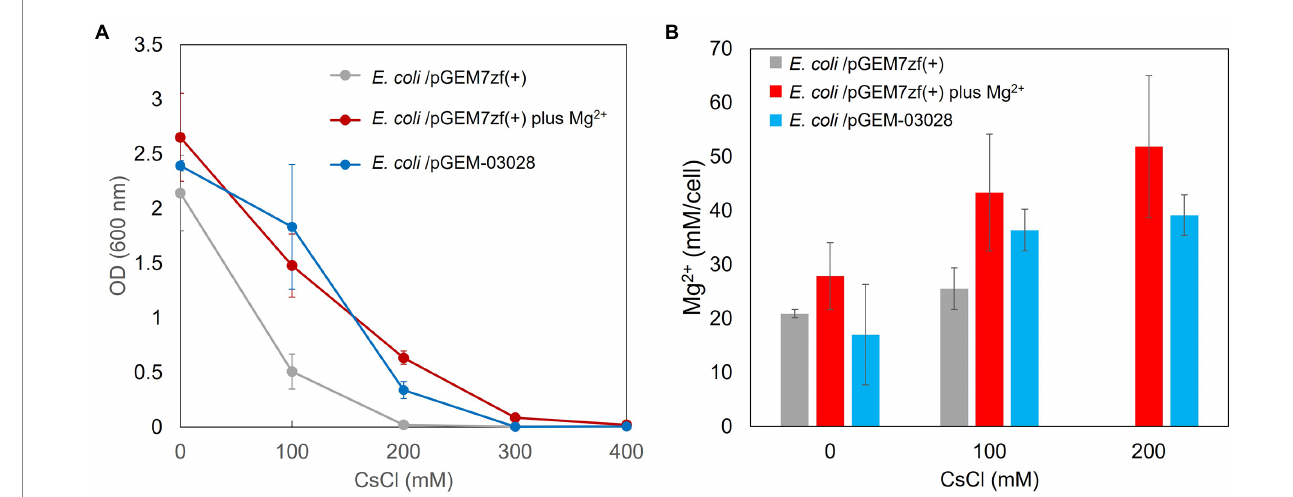
FIGURE 5 Cs + resistance growth test (A) and intracellular Mg 2+ concentrations (B) of Escherichia coli Mach1 harboring pGEM-03028 and E. coli Mach1 harboring pGEM7zf (+) in presence of Mg 2+ . (A) Turbidity (OD 600 ) of E. coli Mach1/pGEM-03028 in LB medium and Mach1/pGEM7zf (+) in LB medium plus 50 mM MgCl 2 at each CsCl concentration and after 16 h of culturing. Error bars indicate SD for three independent experiments. E. coli Mach1/pGEM7zf (+) was used as the negative control. (B) Intracellular Mg 2+ content at each CsCl concentration for E. coli /pGEM-03028 cultured in LB medium (pH 7.5) for 16 h. Vertical axis indicates intracellular Mg 2+ concentration. Horizontal axis indicates CsCl concentration in the medium. Error bars indicate SD for three independent experiments. An empty vector pGEM7zf (+) was used as the negative control.